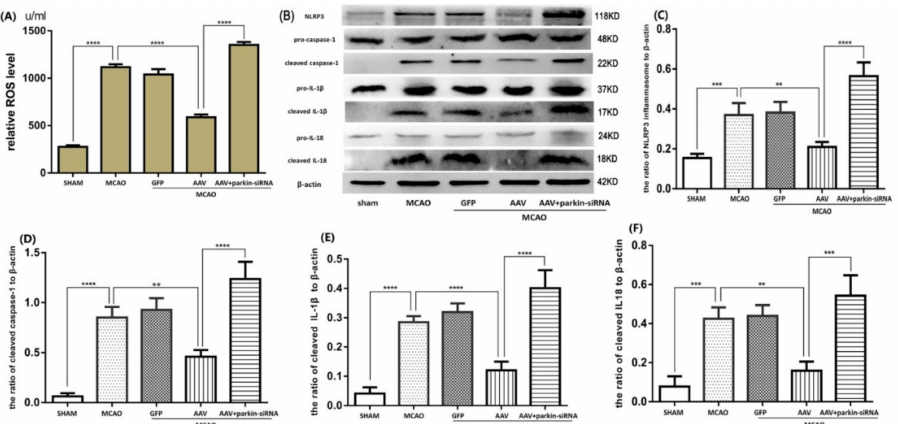
Figure 6. Parkin siRNA reverses the inhibitory e ff ect of ATF4 on NLRP3 inflammasome activation. Representative Western blots showing the levels of NLRP3 protein, cleaved-caspase-1, cleaved-IL-1 β and cleaved-IL-18 ( B – F ), and histograms showing the total ROS levels in the cortex ( A ). Error bars represent mean ± SD. (** p < 0.01, *** p < 0.001 and **** p < 0.0001 vs. indicated group). n = 5 in each group. MCAO, middle cerebral artery occlusion-reperfusion; GFP, green fluorescent protein; AAV, ATF4 overexpression adeno-associated virus; siRNA, small interfering